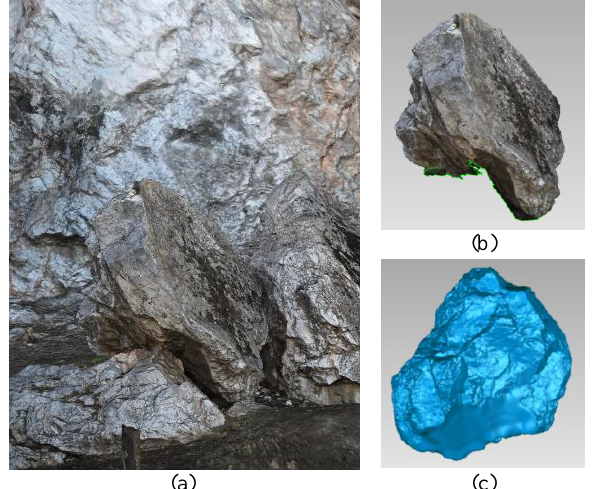
Figure 4: Generation of the 3d model of rock 2B. (a) The 3d model of rock 2B and of the surrounding area, (b) The cropped sub-model, (c)The closed volume of the